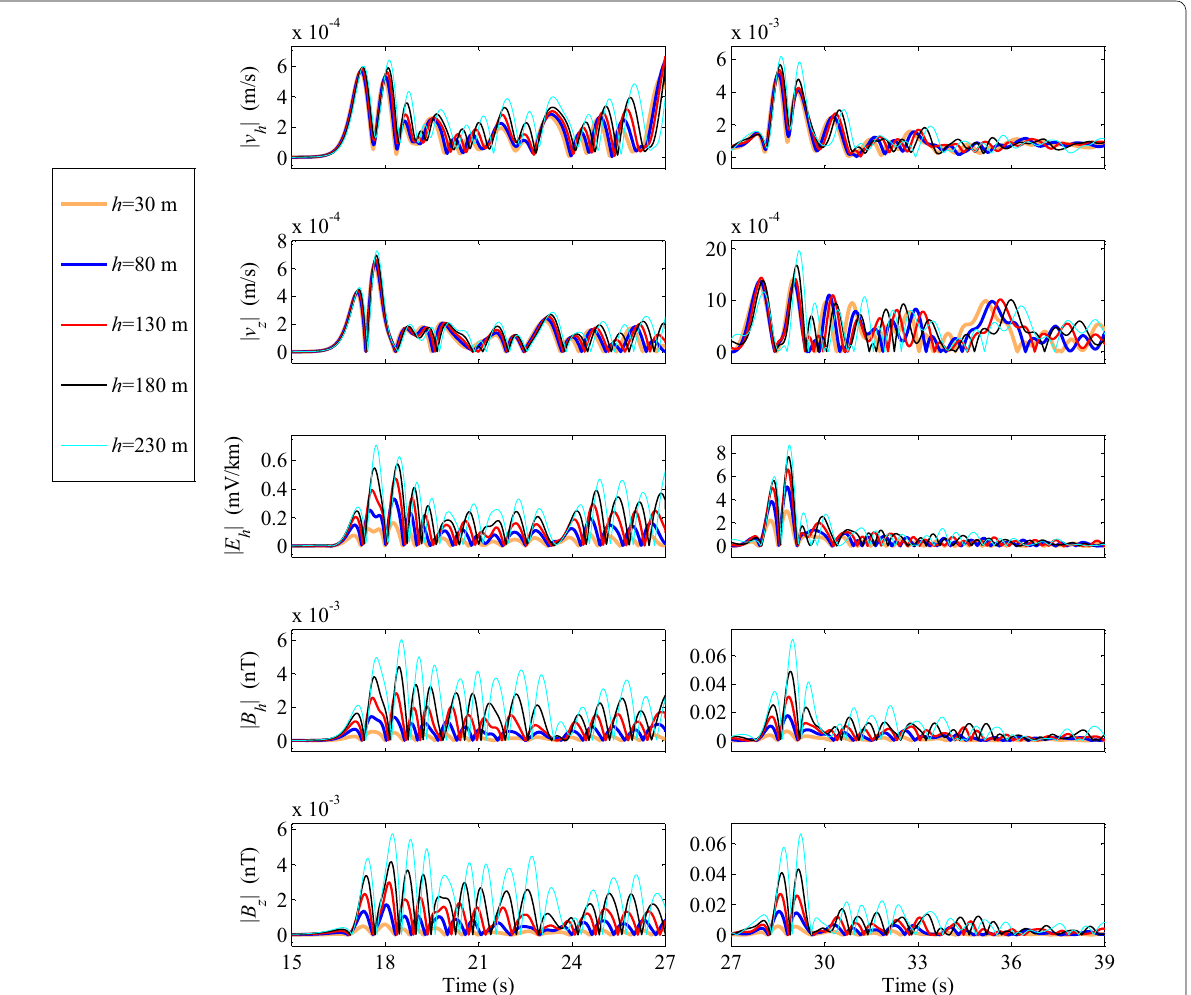
Fig. 12 Influence of aquifer thickness on the amplitudes of seismic and EM wave‑fields. We calculate the absolute amplitudes of horizontal total components and vertical components of the seismic and EM wave‑fields simulated for the receiver located at ( (modified) seven‑layer half‑space models, where the aquifer thickness is set to be h effect is considered, and the artificial scattering conversion coefficient is set as C st